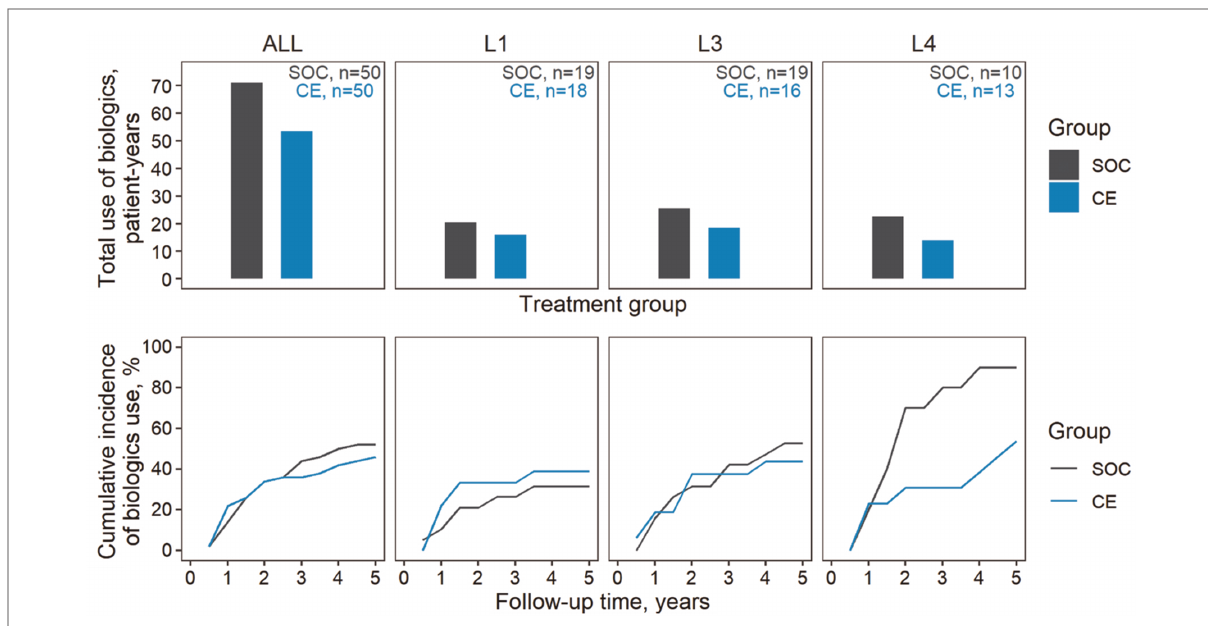
FIGURE 1 Biologics use. Biologics outcomes for the two management groups. Top, cumulative use of biologics through the fi ve-year follow-up; bottom, cumulative incidence of biologics prescription. Results are strati fi ed horizontally by diagnosed location: ALL, all diagnosed sites; L1, L3, and L4,